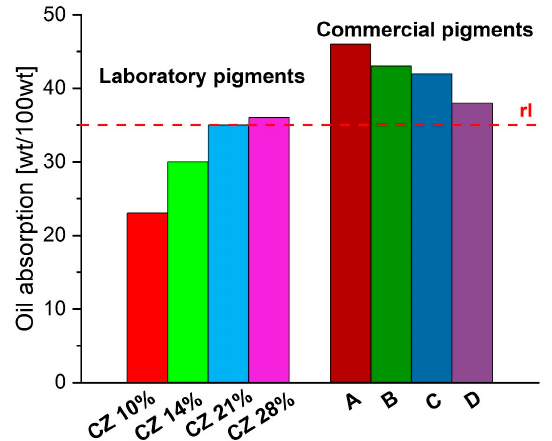
Figure 12. Oil absorption for laboratory and commercial pigments (rl—reference level).